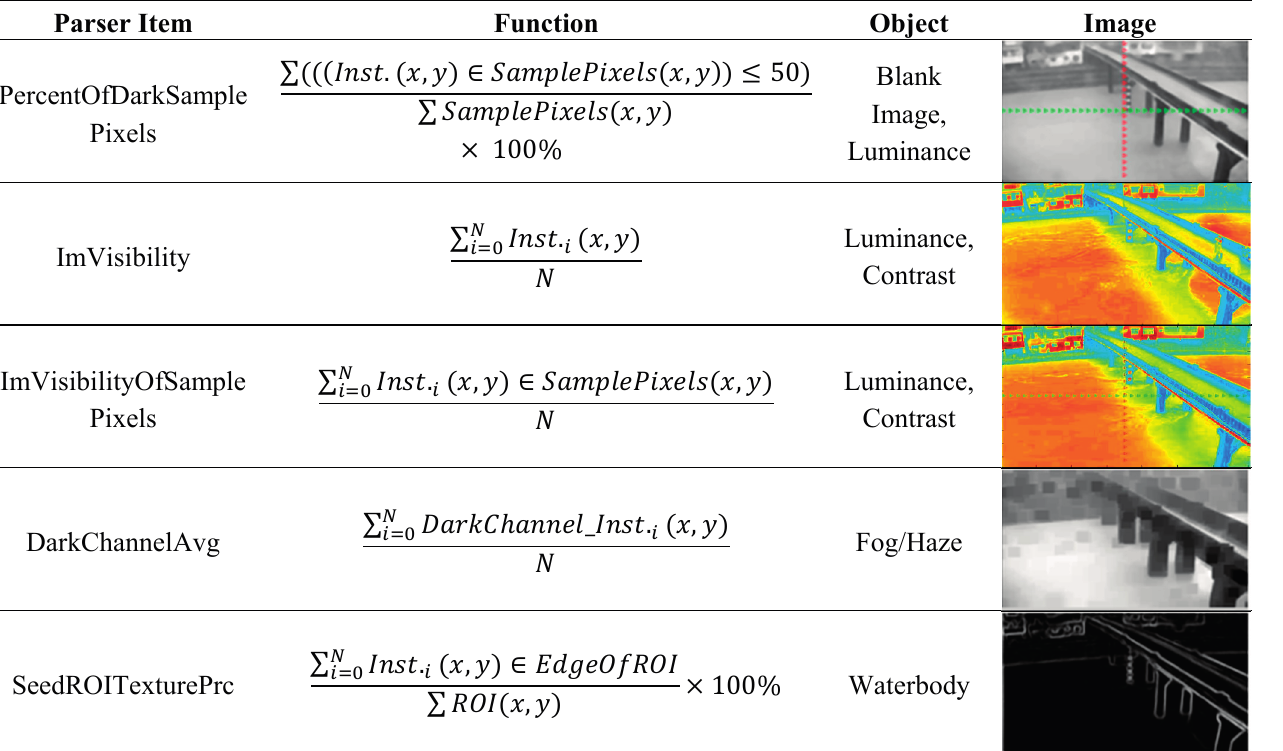
Table 1. Parser items and its visual meaning, applied condition, and processed